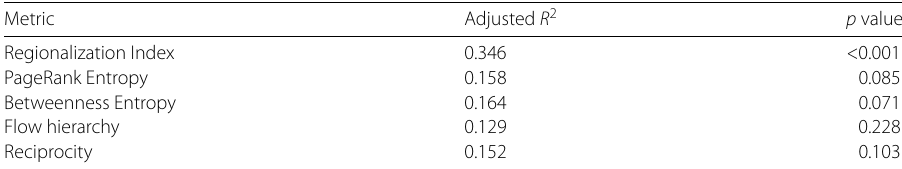
Figure 6 The regionalization index and the proportionnottransfered are positively associated. We performed an ordinary least-squares regression between the regionalization index and the proportion of all infants born in a given community who were never transferred. In this regression, we controlled for the total number of hospitals in each community and the fraction of each community that were VON member facilities (we only had data on the proportionnottransfered for VON member hospitals). The results were robust to removal of the point in the lower-left corner where there were all infants were transfered and the regionalization index was zero (regression results with “outlier” removed: adjusted R 2 = 336; p < 0.001)